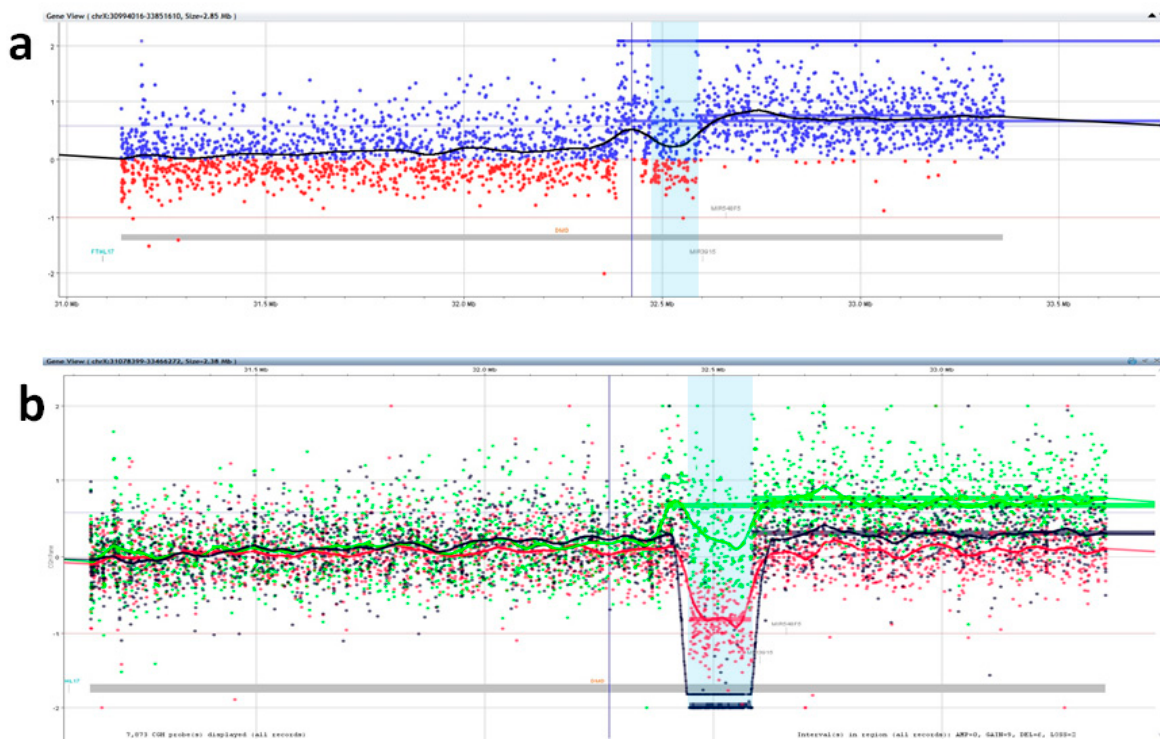
Figure 3. MotorChip Analysis. Blue and red dots correspond to Log2 positive or negative ratio values (Y-axis) for each probe present in this specific chromosome interval (X-axis). The light blue bar corresponds to the 16–29 exons of DMD. CGH panels showing the Log2 ratio profile of probes as a colored line: ( a ) complex duplication in the maternal aunt (II-3, black line); ( b ) the affected male (III-1, black line), his carrier mother (II-1, red line) and his maternal aunt (II-3, green line).